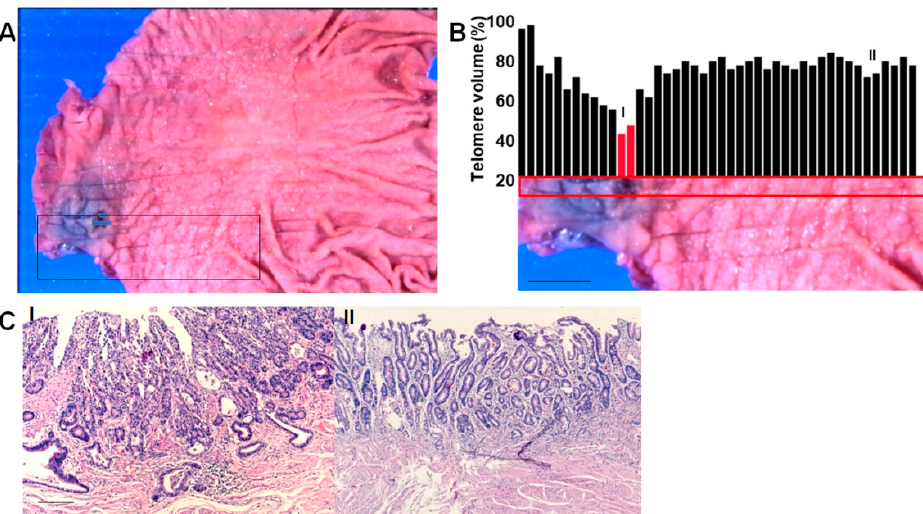
Figure 2. Short telomere lesion in gastric mucosa—Case 3. ( A ) Macroscopic image of mucosal aspect of the stomach with two gastric cancer lesions (Case 3 in Table 1). Scale bar, 1 cm. Boxes, TV examined areas showed in panel B, Color indicator, invasive depth and area. ( B ) TV of the gastric mucosa. Bar graphs show TV at the respective points in the area within the red box. Scale bar, 1 cm. ( C ) HE-stained tissue from areas I–III indicated in panel ( B ). Scale bar, 100 μ m. M, mucosal layer; TV, telomere volume; HE, hematoxylin & eosin staining.